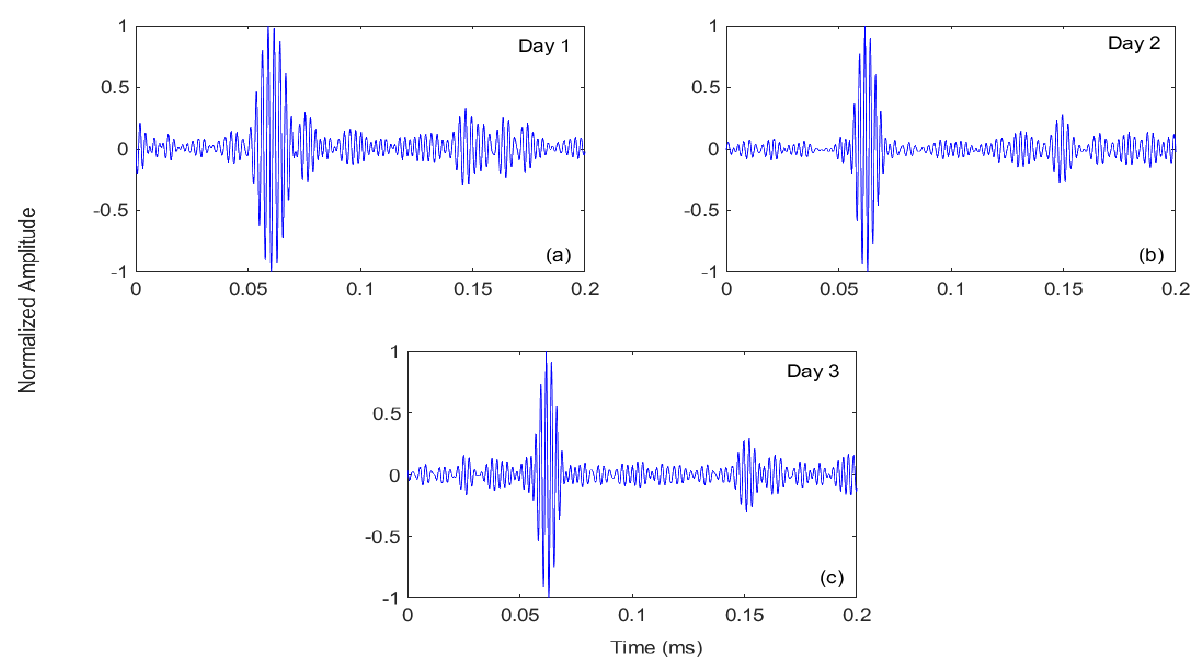
Figure 15. The signals captured on consecutive days: ( a ) day 1, ( b ) day 2 and ( c ) day 3, at specimen B that has a surface horizontal defect.